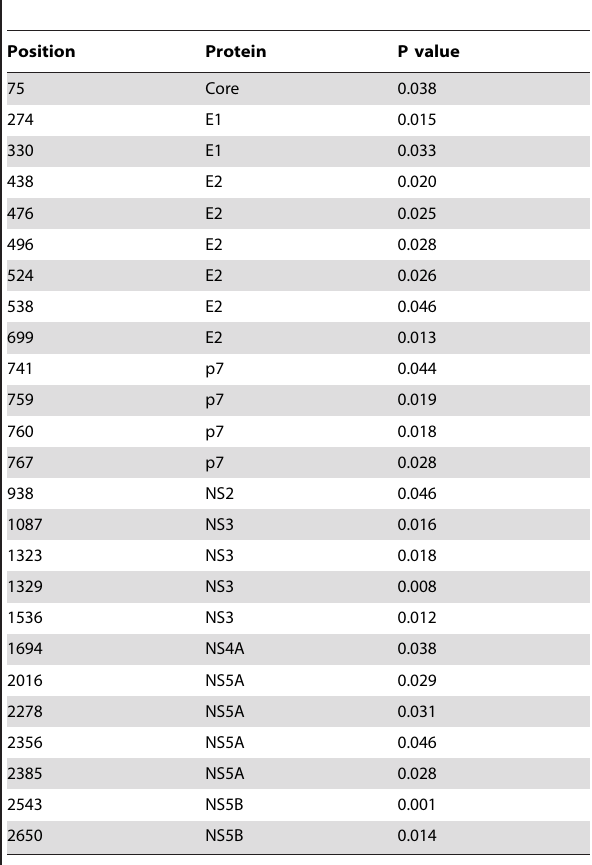
Table 2. Positions where the distribution of amino acids differ in HCC and cirrhotic control